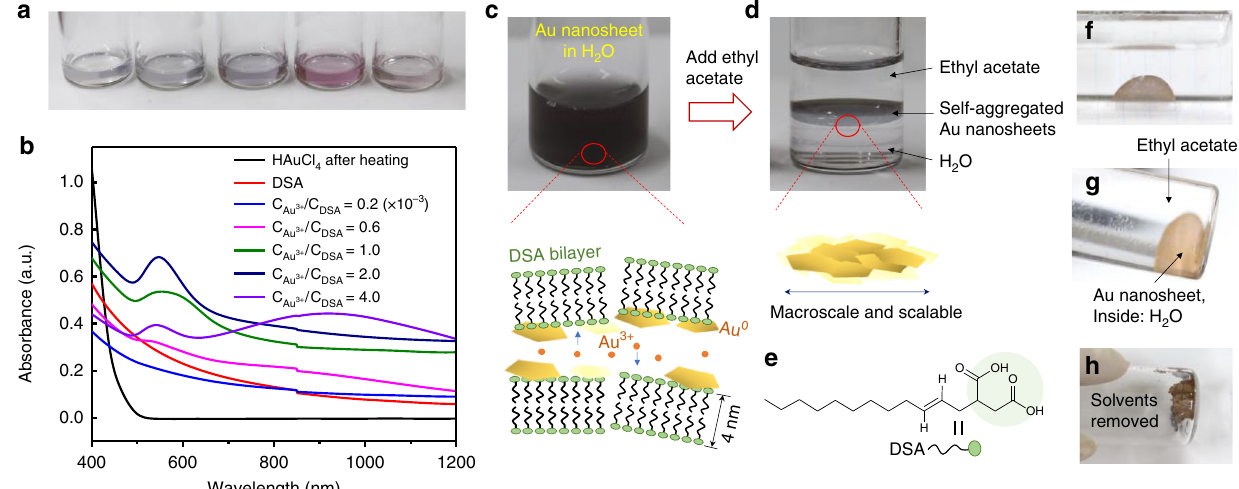
Fig. 1 2D con fi ned growth of gold nanosheets and their self-assembly at the liquid − liquid interface. a Photographs of as-prepared Au 0 nanostructures synthesized in DSA aqueous solution (53 °C) for 20 min with addition of different Au 3 + concentrations. From left to right C Au 3 + /C DSA mole ratio: 0.2, 0.6, 1.0, 2.0, and 4.0 × 10 − 3 . b Corresponding UV − Vis − NIR absorbance spectra of solutions. c Synthesized gold nanomaterials dispersed in water containing DSA bilayer structures. d Gold nanosheets self-assembled at the liquid − liquid interface. e Chemical structure of the DSA molecules. f , g The nanosheet assemblies prefer to exist at the liquid − liquid interface with a spherical shape. h The nanosheet assemblies show a brown colour after solvent